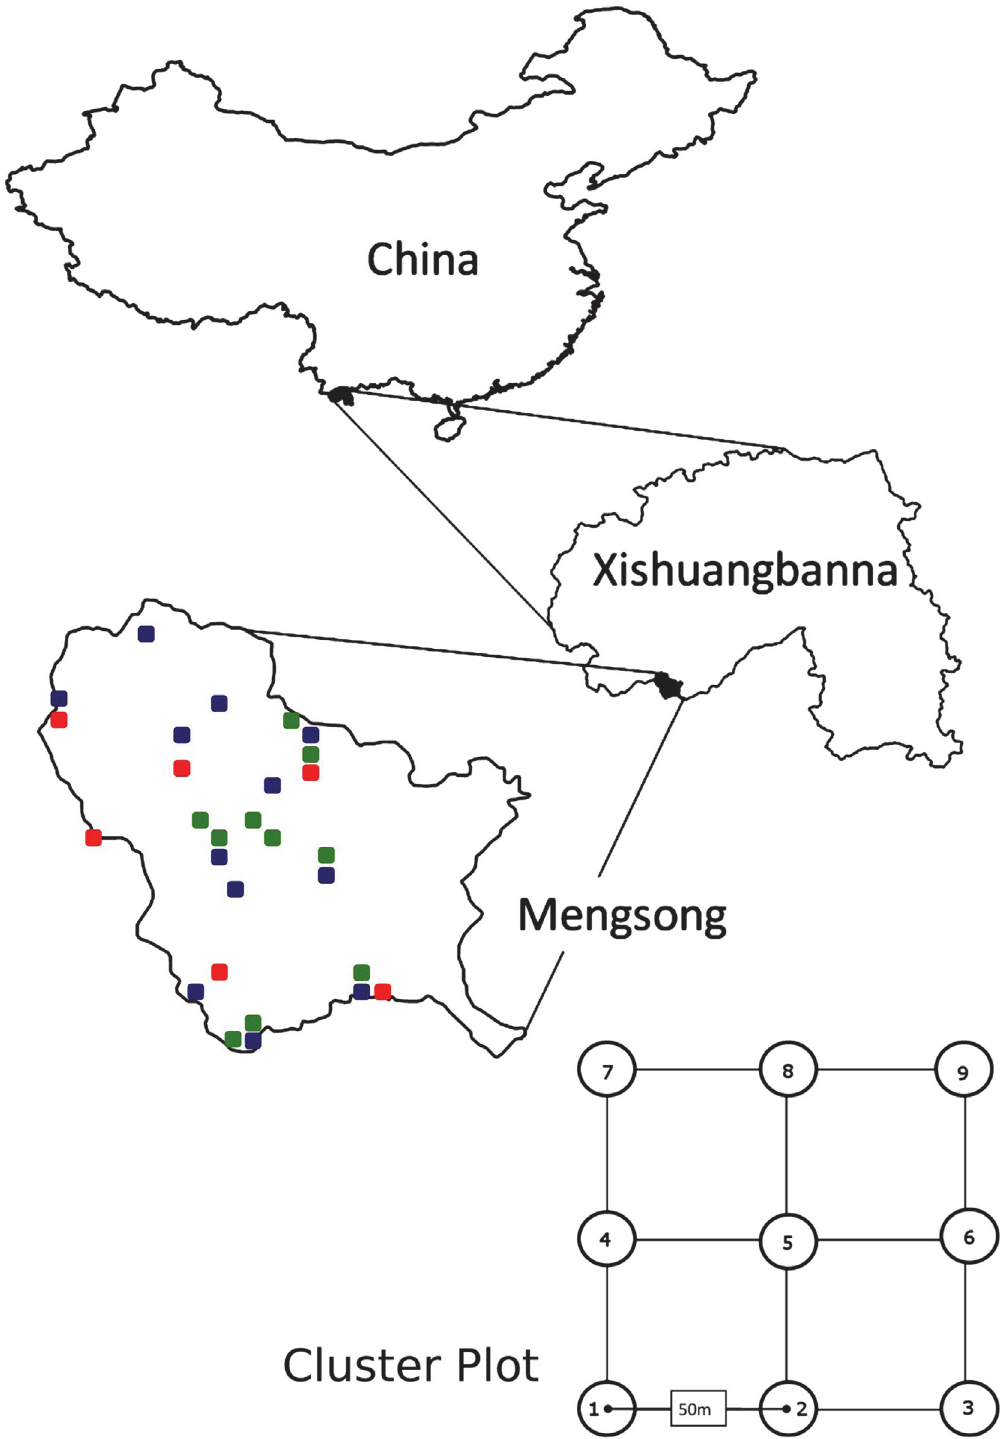
Fig 1. Map of the study site in Xishuangbanna Prefecture, China, and 28 plots across a disturbance gradient (green: near-pristine forest; blue: degraded forest; red: open landscape) in the Mengsong Township. Each plot comprised nine subplots in a 3 × 3 array with 50 m spacing between